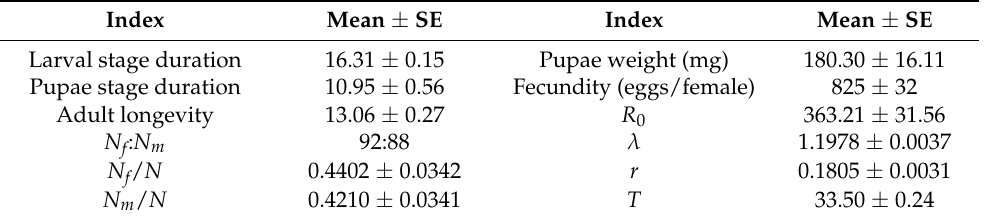
Table A2. Population parameters of stock FAW population fed on corn seedlings in the